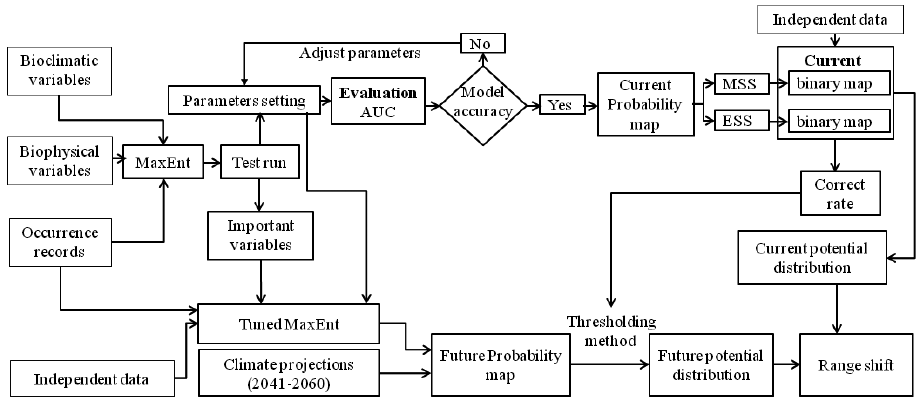
Figure 2. The modeling process for generating future potential distribution of Sapindus mukorossi in China (based on MaxEnt).